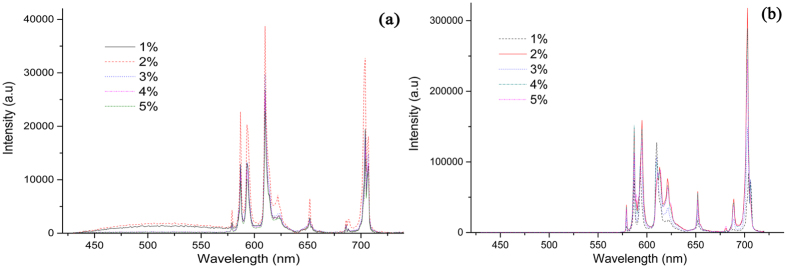
Emission spectra of Bi4Si3O12: xEu3+ (x = 1 at%, 2 at%, 3 at%, 4 at%, 5 at%) phosphors under 271 nm (a) and 393 nm (b) excitation at room temperature